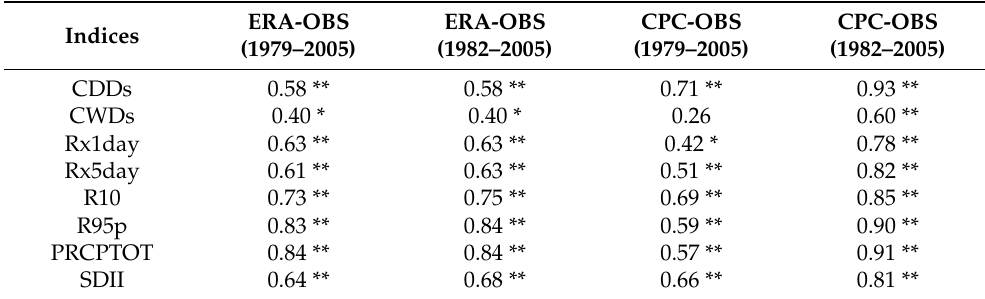
Table 2. The CCs of eight precipitation indices between ERA/CPC and OBS in periods of 1979–2005